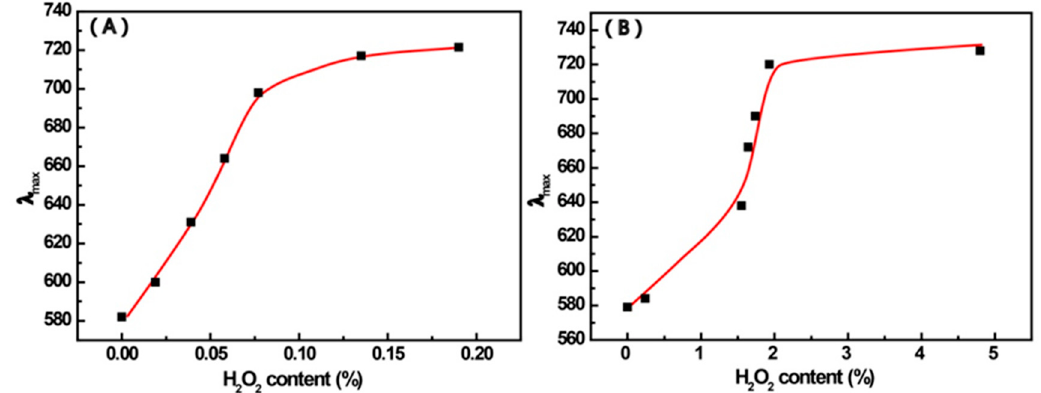
Figure 4. The change in the wavelength of maximum absorbance with the content of H 2 O 2 in Mixt.1 ( A ) and Mixt. 2. ( B ). ( A ) and Mixt. 2 ( B